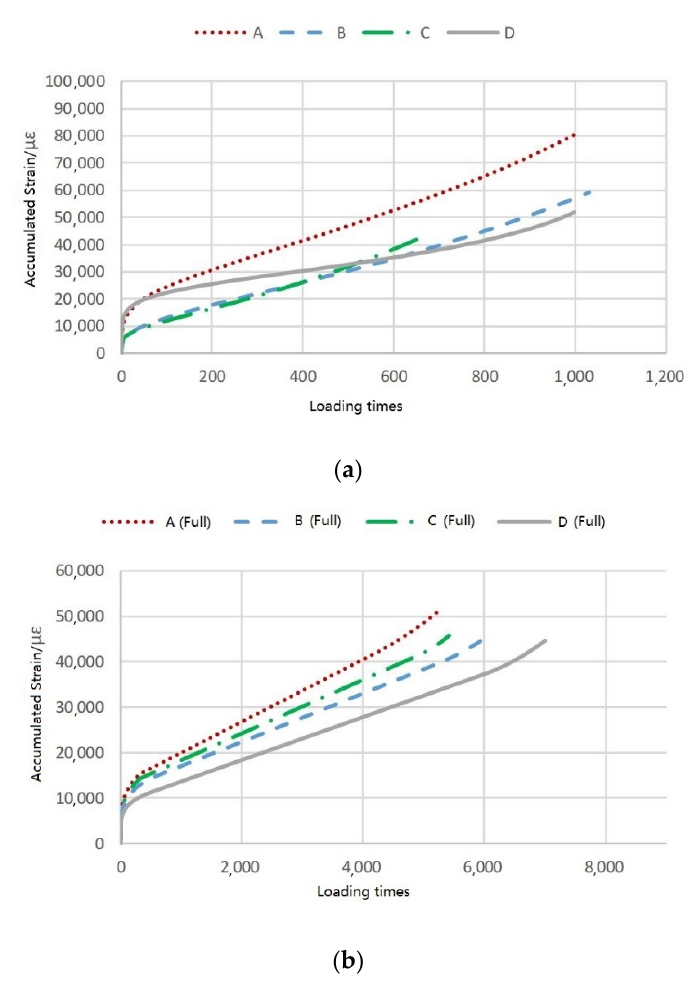
Figure 8. Accumulated strain for ( a ) CR mixtures, and ( b ) corresponding full-depth specimens. Table 5. Three-phase models of dynamic creep test.